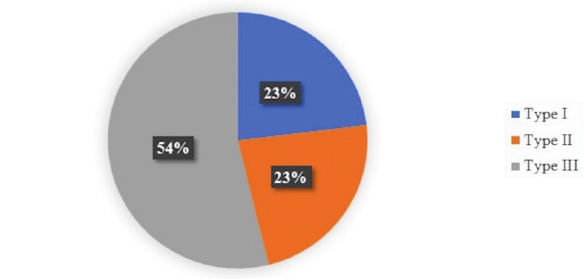
Figure 3 - Distribution of patients by aortic dissection types